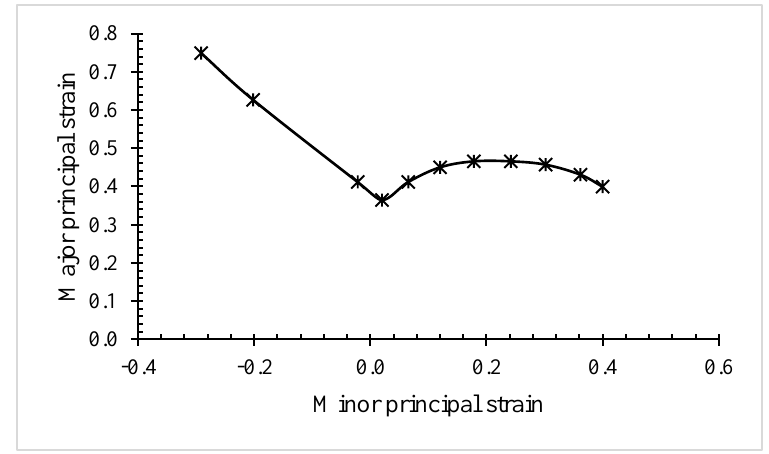
Figure 8. FFLD of DP600 steel.